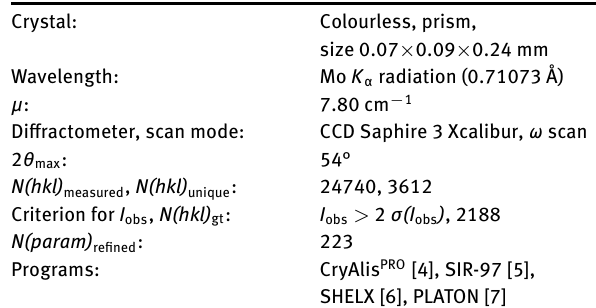
Table 2: Fractional atomic coordinates and isotropic or equivalent isotropic displacement parameters (Å 2 ).